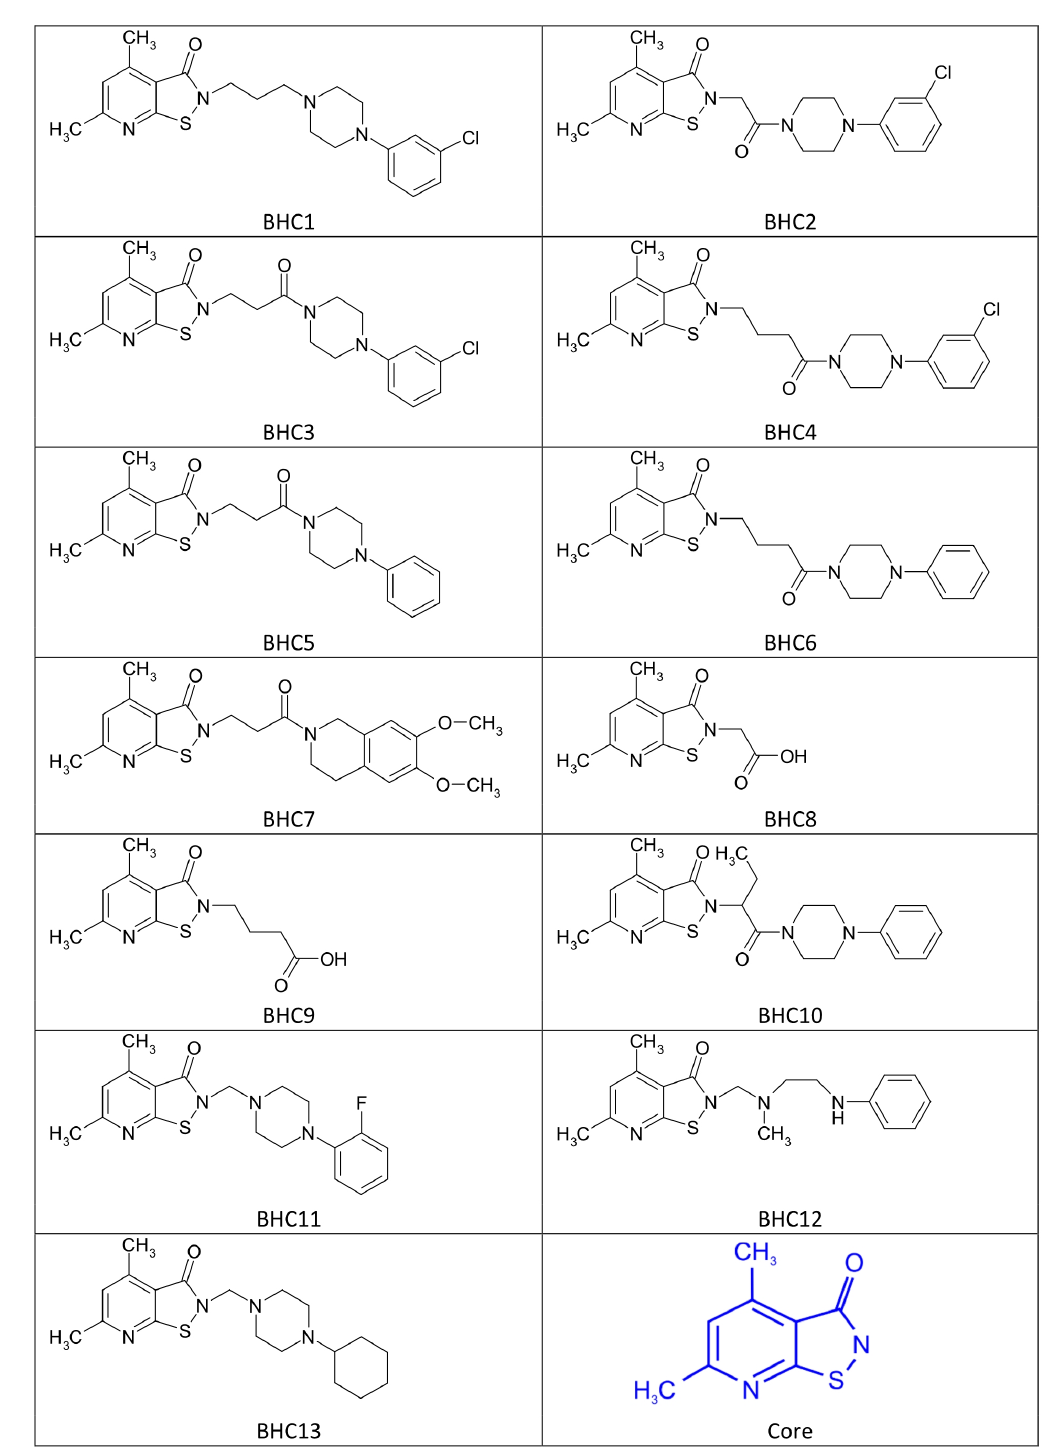
Figure 2. Chemical structures of bi-heterocyclic compounds (BHC1-13) used in the studies. The common core is marked in